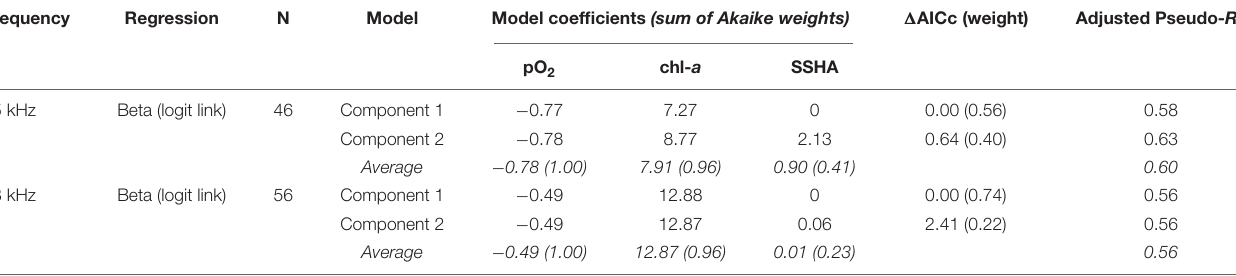
TABLE 3 | Model parameters (component models and averages) from fitted regressions of observed vertical migration proportion (DVM p ) for the two ADCP frequencies. Frequency Regression